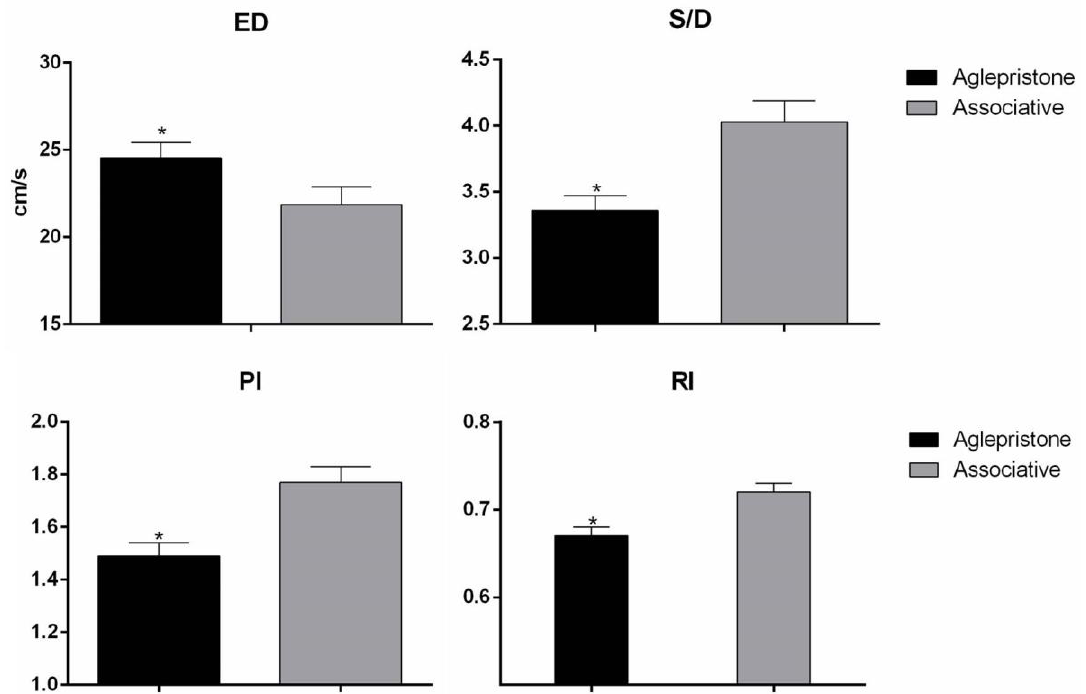
Figure 4. End diastolic blood velocity (ED; cm/s), peak systolic: diastolic velocity (S/D), pulsatility index (PI) and resistance index (RI) of the artery uterine in the Aglepristone and associative groups. * indicate significant differences between groups ( p < 0.05) .